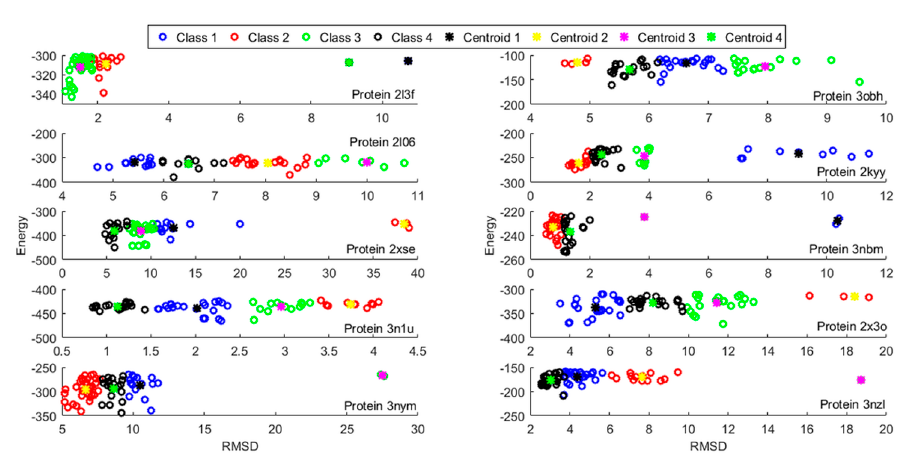
Figure 4. Template classification based on energy and structural considerations.